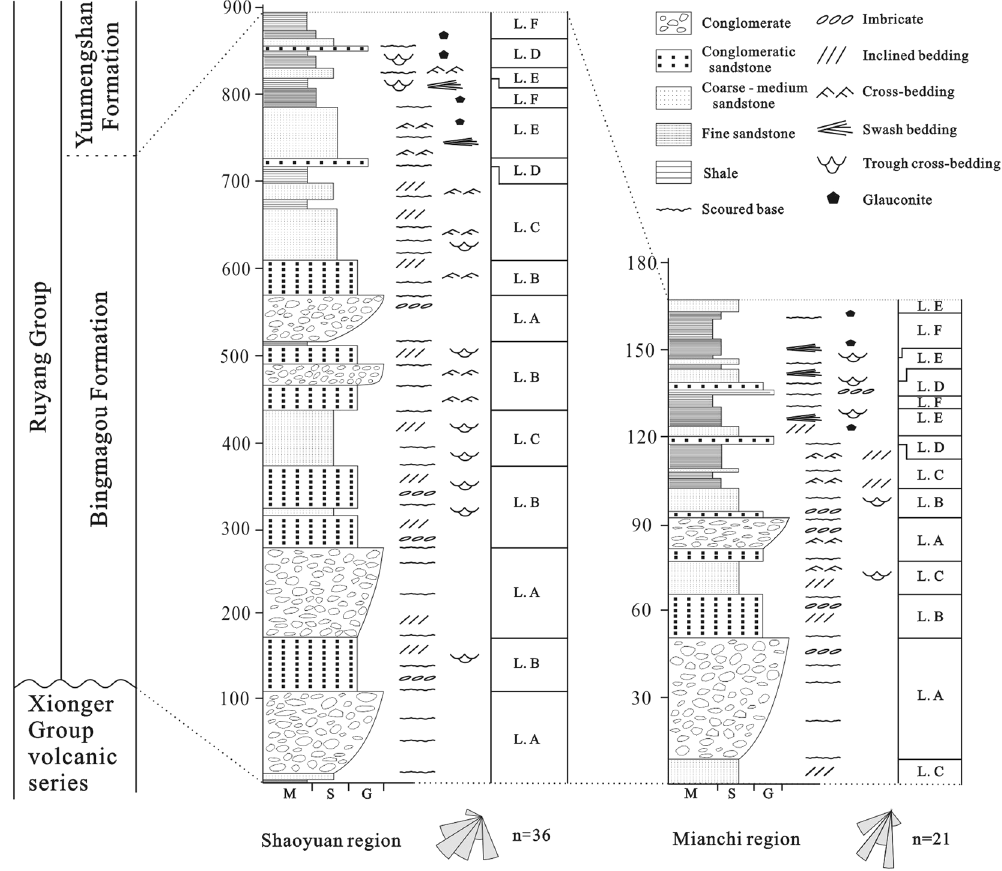
Figure 3. Comprehensive histogram of the Bingmagou Formation in the Shaoyuan and Mianchi regions. M = Mud; S = Sand; G =